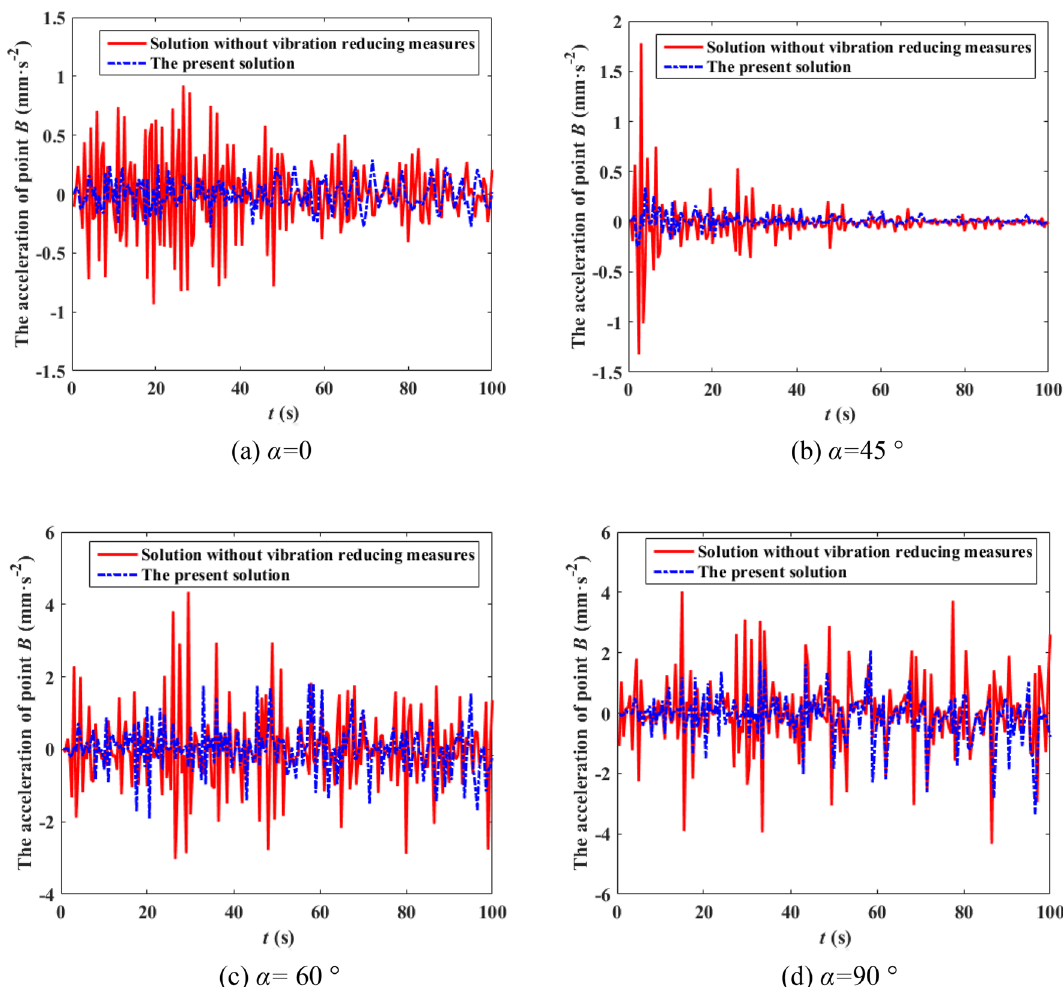
Figure 11. Acceleration time history curve of point B under different wind direction.